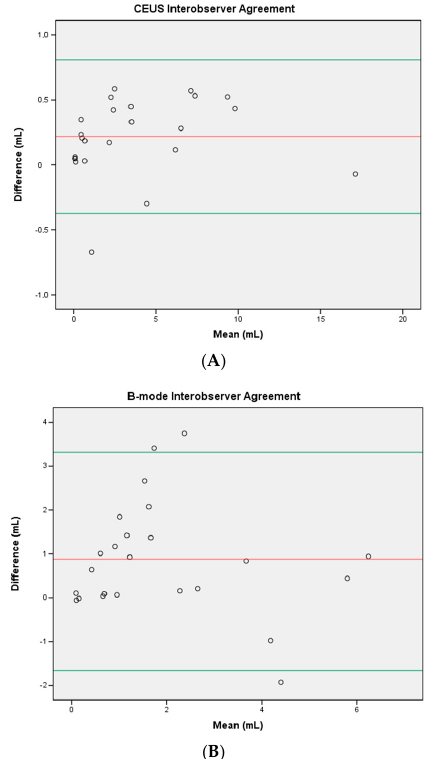
Figure 1. Bland–Altman plots showing inter-observer reproducibility of measurements for CEUS ( A ) and B-mode ( B ) assessments. The x-axes show the mean of the volume measurements, and the y-axes show the differences between the measurements. Red lines = mean difference between readers, and green lines = 95% (1.96 SD) limits of agreement.